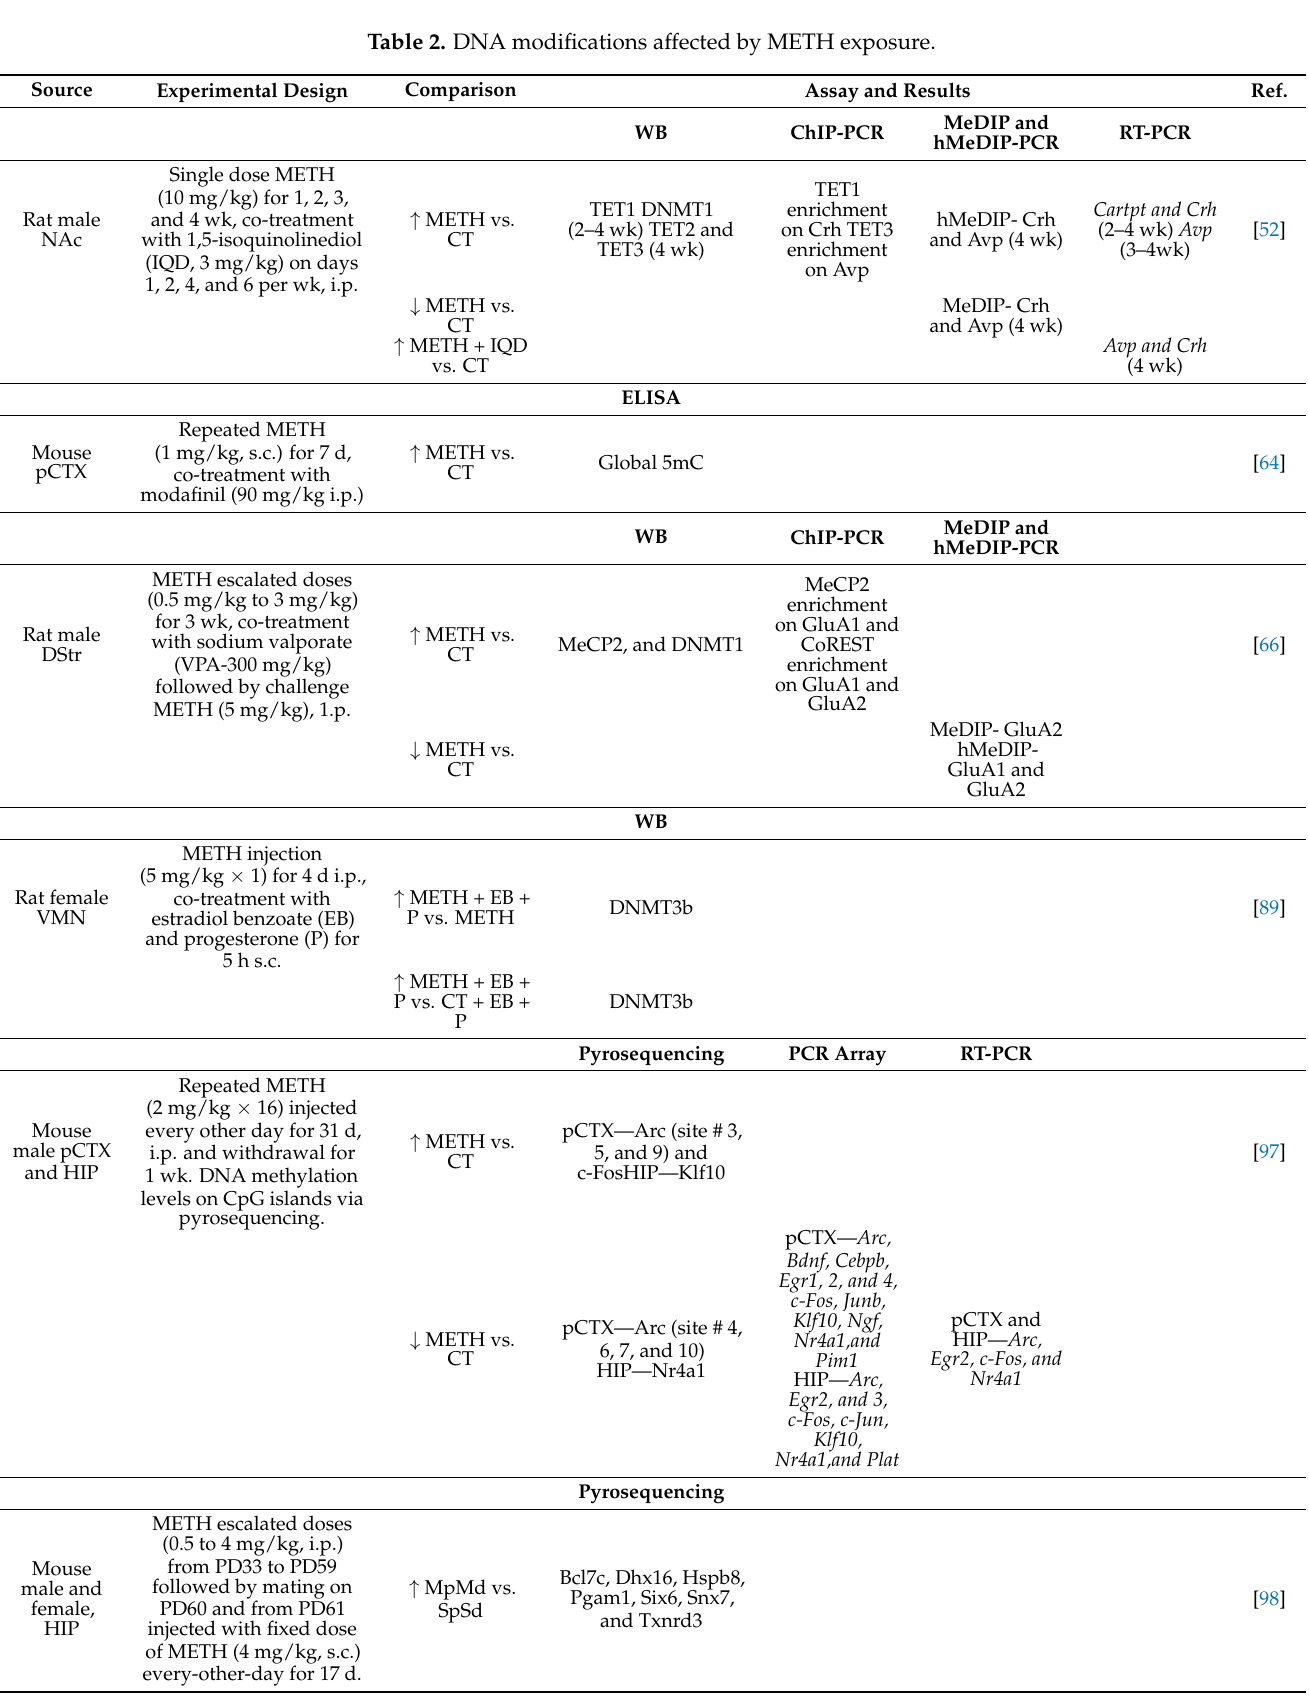
Table 2. DNA modifications affected by METH